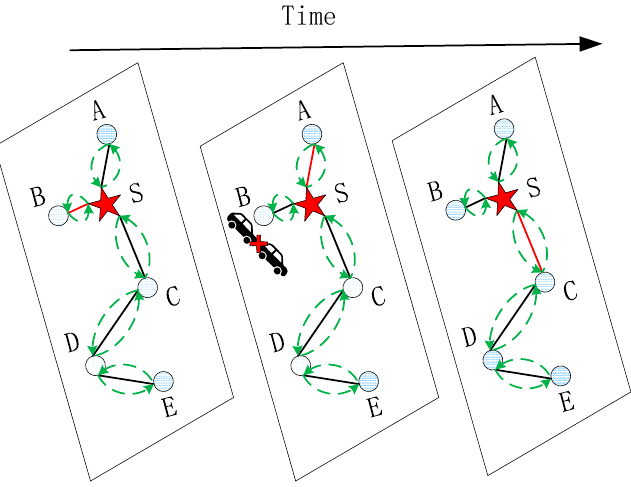
Figure 1. The dynamic spatial–temporal correlation of traffic data.